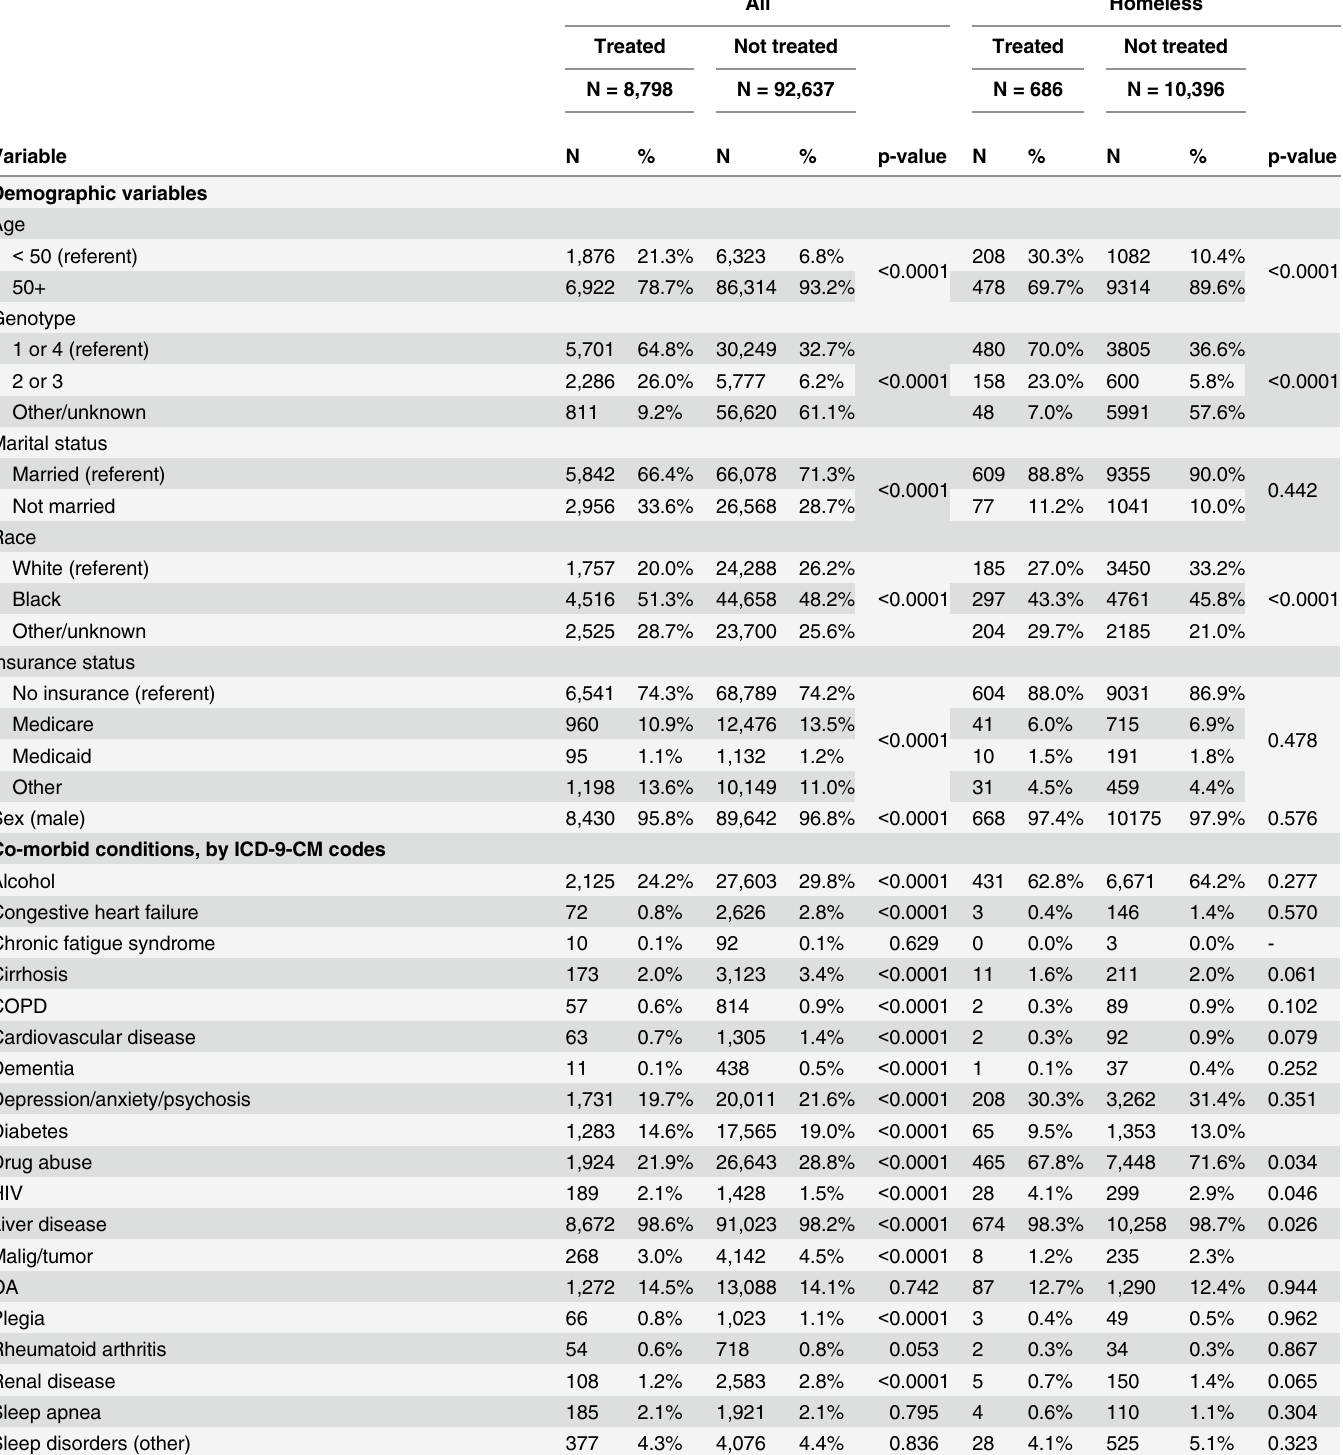
Table 1. Demographic characteristics of 101,444 U.S. Veterans with chronic hepatitis C (HCV) infection who were treatment na ï ve for HCV, 2004 – 2009.